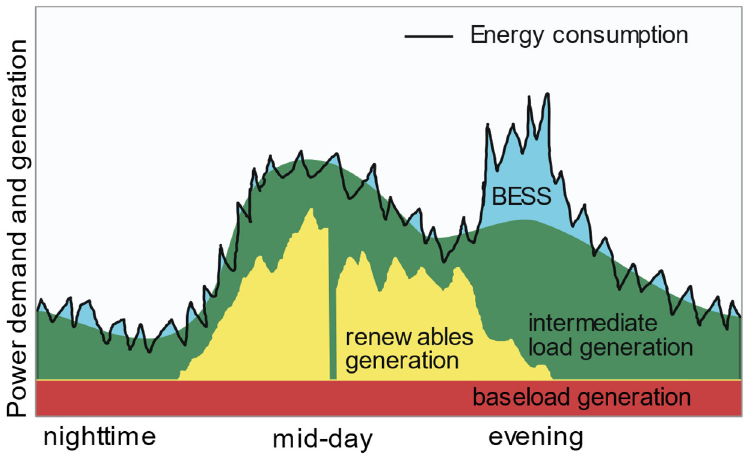
Figure 1. Example of a power grid load pro fi le with a ba tt ery energy storage system.